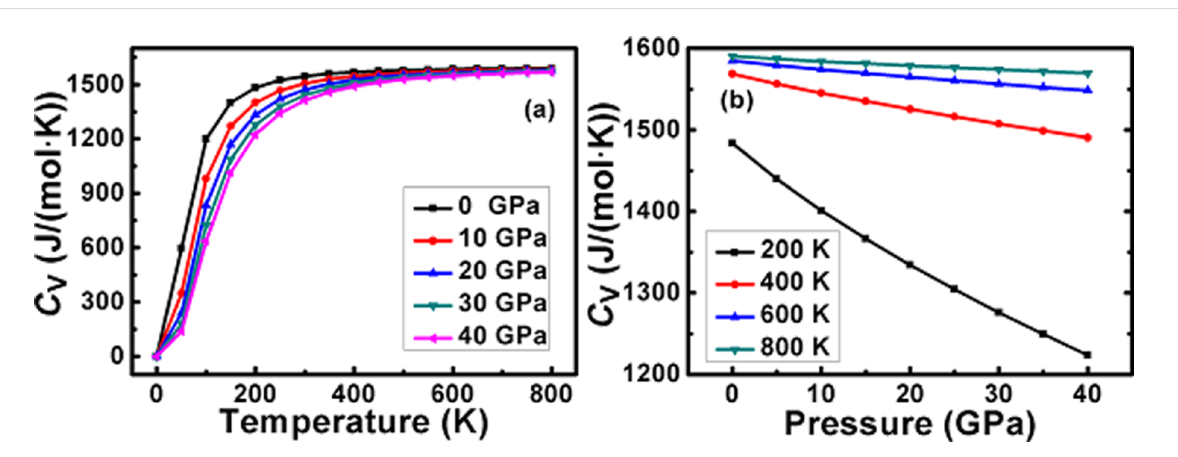
Figure 6: Variation of heat capacity as a function of (a) temperature and (b) pressure for the π -SnSe